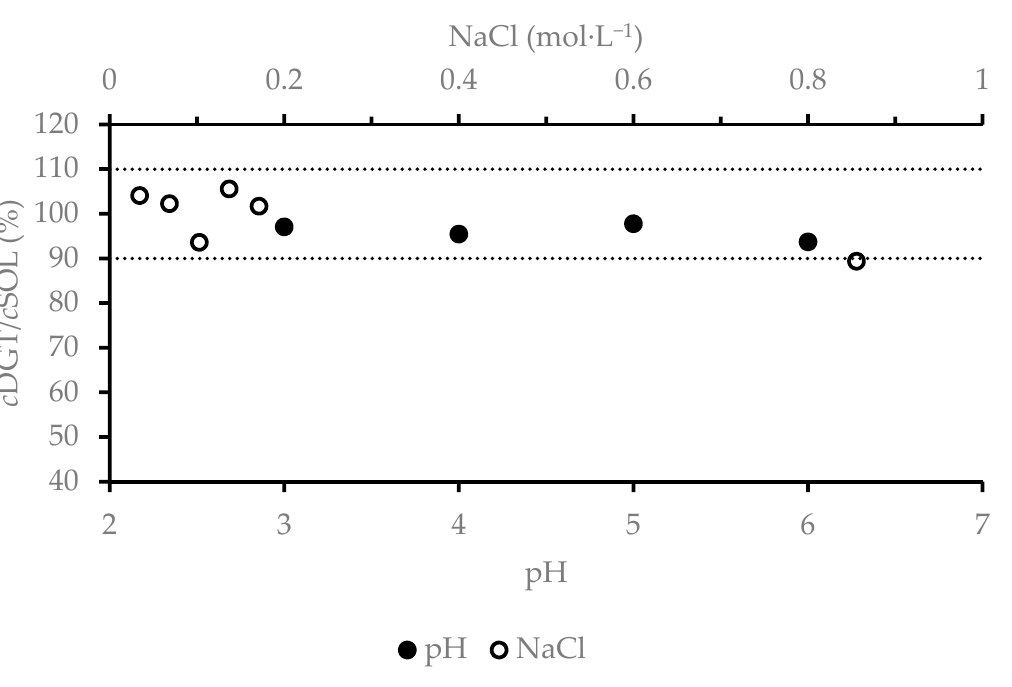
Figure 2. Influence of pH and NaCl concentration on recovery. RSD < 10 %.